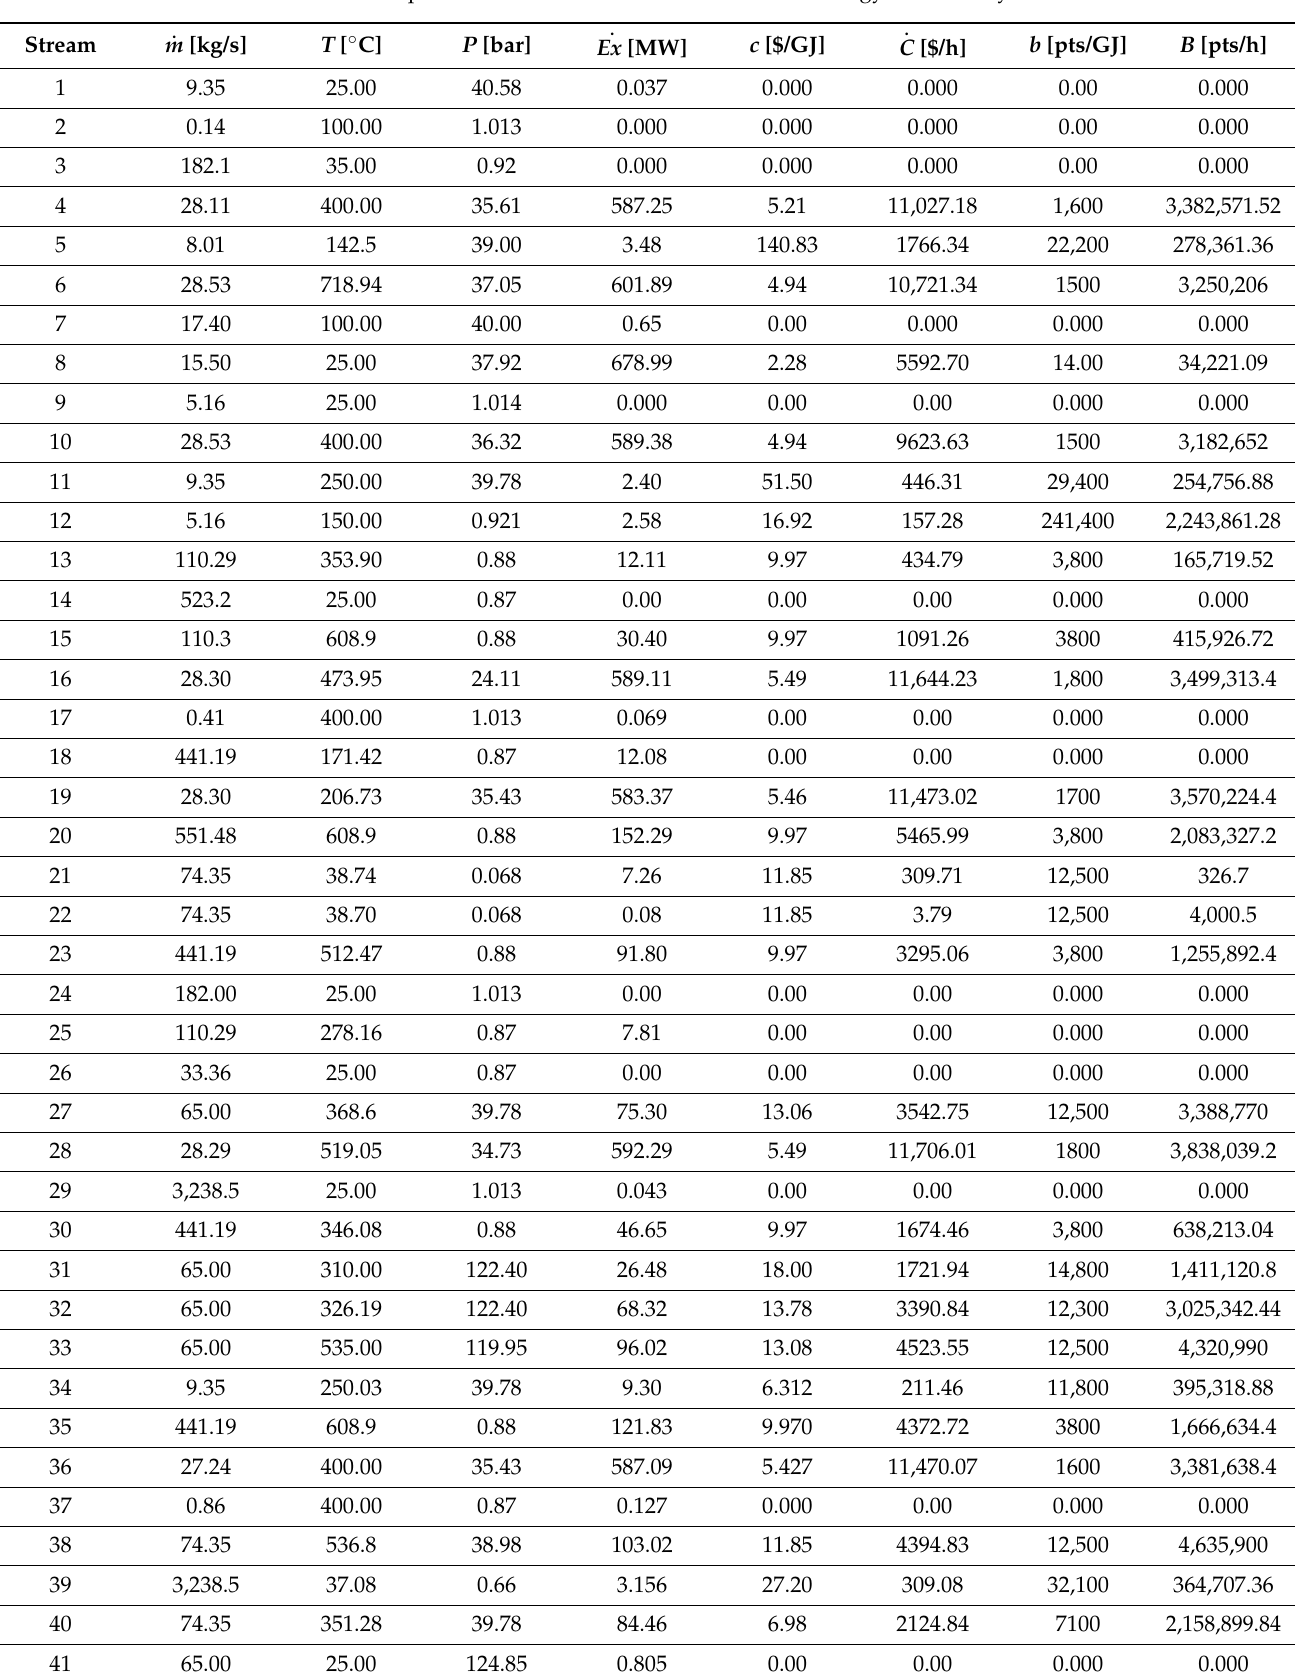
Table 5. Stream specifications obtained from conventional exergy-based analyses.